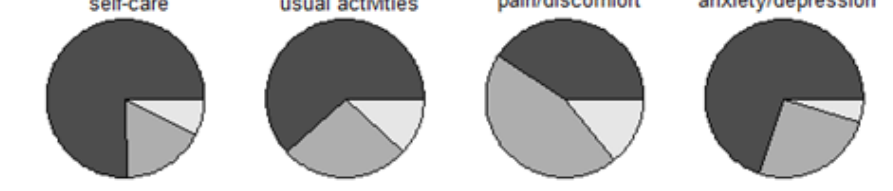
Figure 1. Comparison of the EQ-5D dimensions of the women with osteoporosis in the study group with the ENSE 2011 women